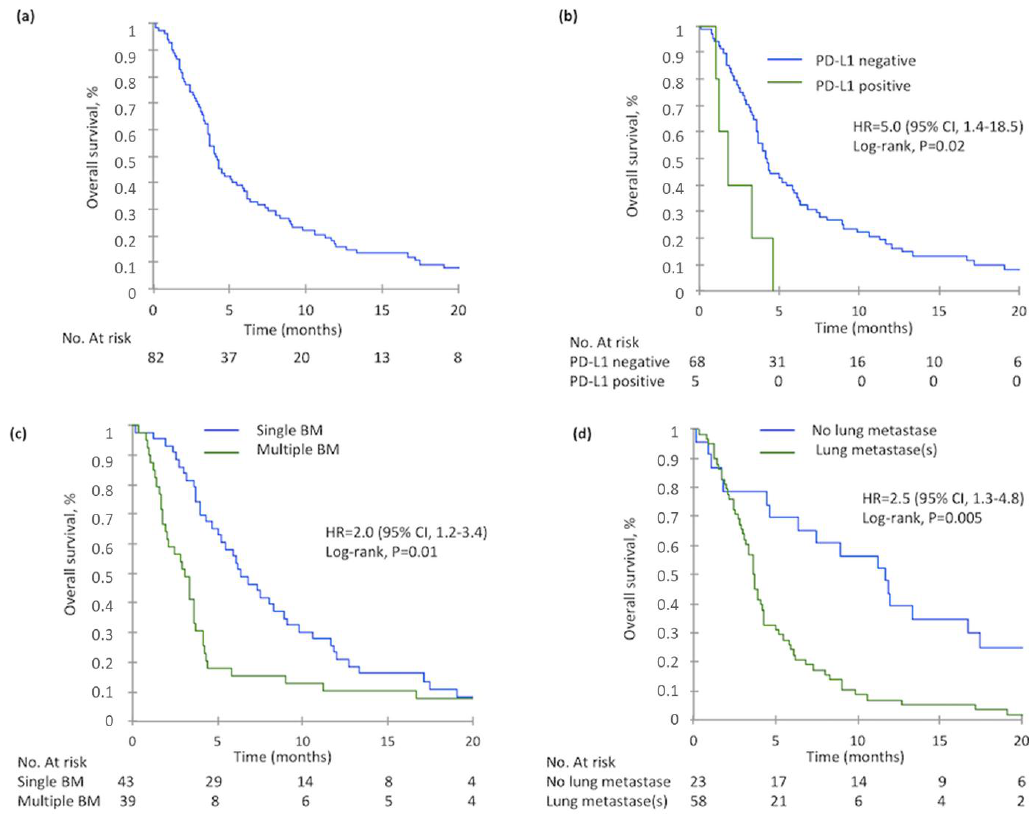
Figure 1. Overall Survival at brain metastasis(es) diagnosis in the whole population and according to PD-L1 expression, number of brain metastasis(es) and the presence of lung metastasis(es): ( a ) Overall survival of 82 patients at BM diagnosis, ( b ) Overall survival according to PD-L1 expression in primary tumor, ( c ) Overall survival according to the BM number, ( d ) Overall survival according to the presence of lung metastasis(es) at BM